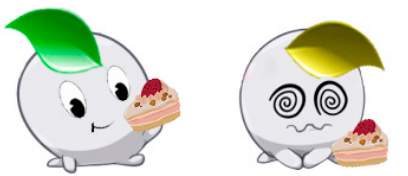
Figure 4. Representations of happiness ( left ) and pain ( right ) during eating.